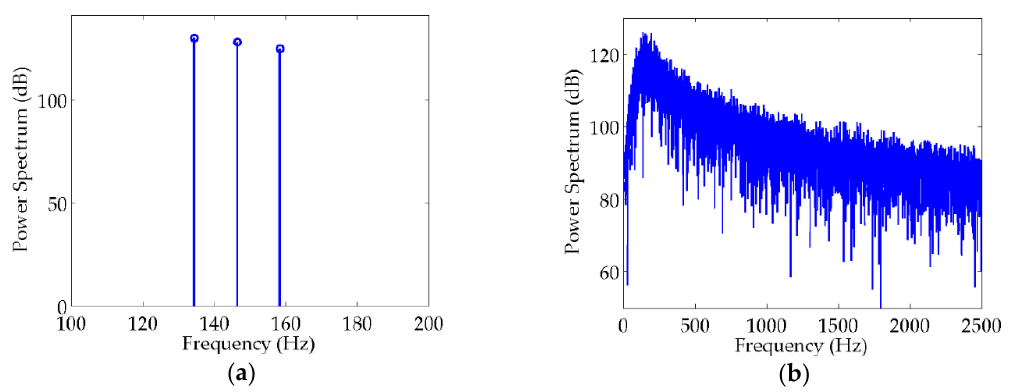
Figure 3. Simulation of ship ‐ radiated acoustic signal: ( a ) discrete spectra; ( b ) continuous spectrum.